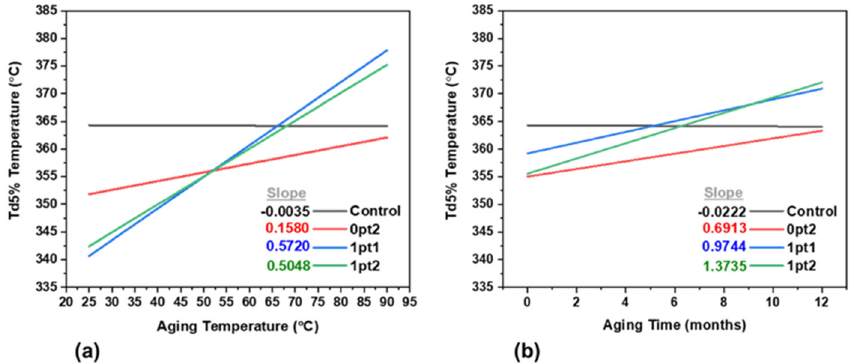
Figure 11. Linear regression of thermally aged samples ( a ) as a function of aging temperature and ( b ) as a function of aging time.